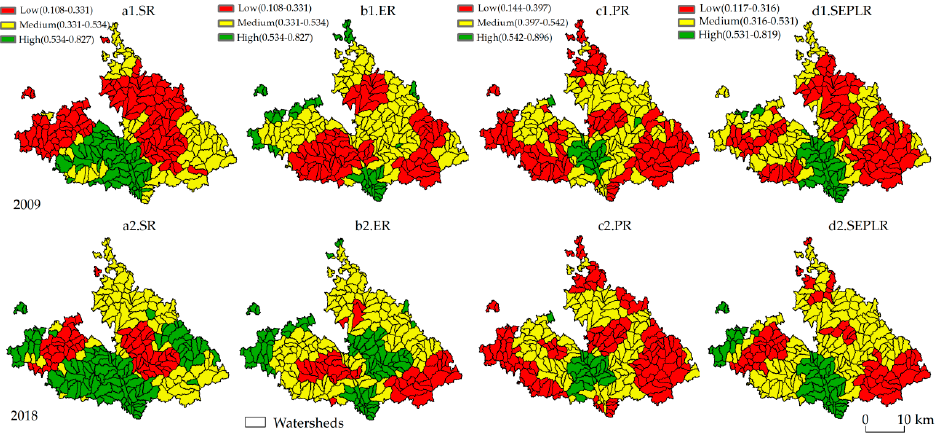
Figure 3. Spatial distribution of SEPLR from 2009 to 2018 in Mizhi County .